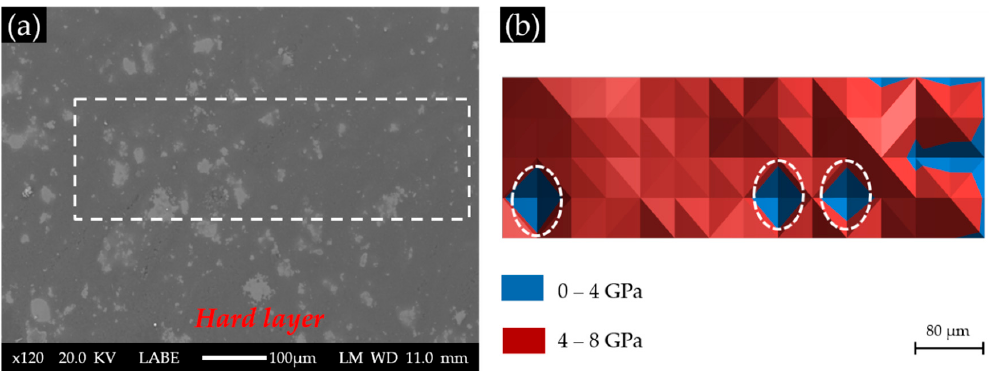
Figure 8. ( a ) The back-scattered electron (BSE) image of S1 with a Ca(OH) 2 paste addition of 1 g; ( b ) the corresponding elastic